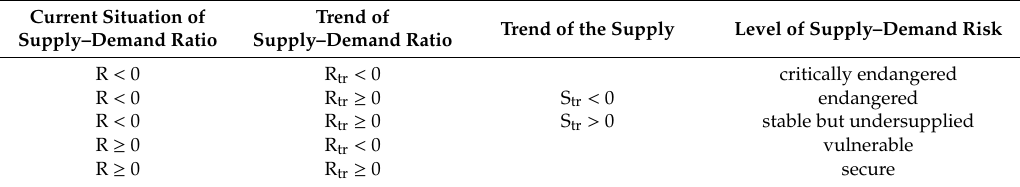
Table 2. The classification of supply–demand risks of ES